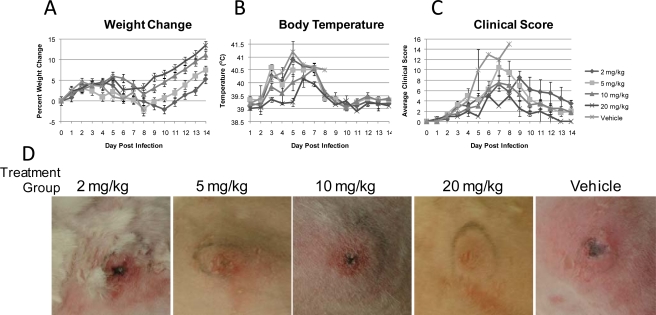
Clinical observations for evaluation of minimum dose of CMX001 required for protection from RPV when treatment is begun 1 day post infection. Animals were dosed at concentrations and schedules as outlined in Table 2. (A) Average weight change for each group. (B) Average body temperatures for each group. (C) Average clinical scores for each group. Error bars represent SEM. (D) Representative photos of primary lesions for treatment groups at 5 dpi.